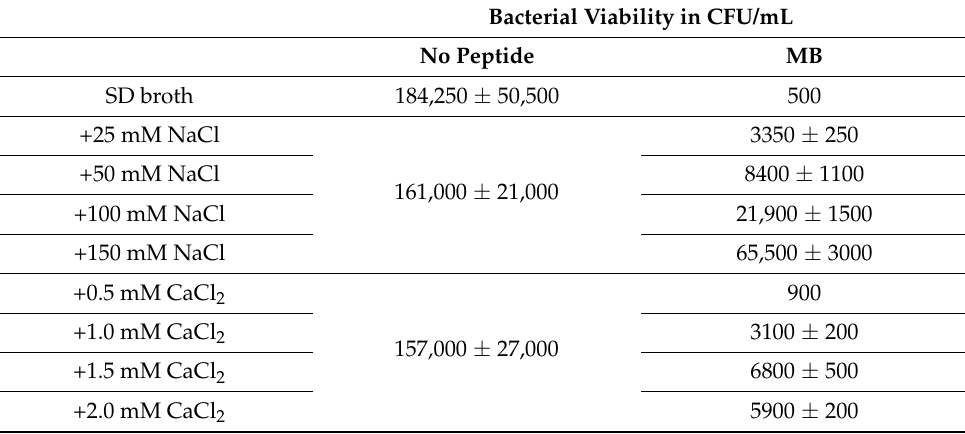
Table 3. Effect of monovalent and divalent cations on antifungal properties of MB. C. parapsilosis 1002 strain was used to ascertain the fungicidal properties of